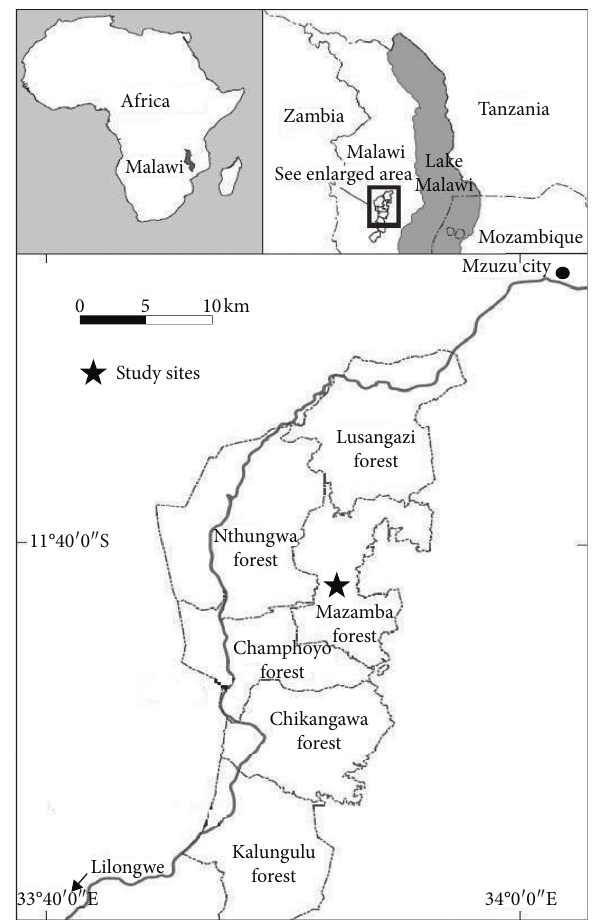
Figure 1: Map showing location of Mazamba forest station, adapted from